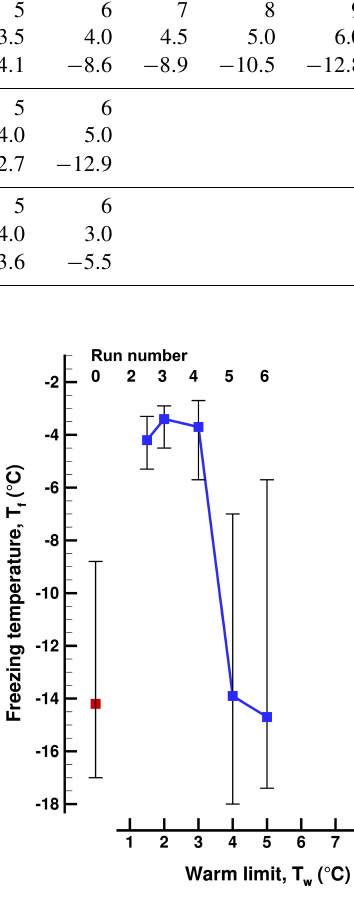
Figure 3. Freezing temperatures in the sequence of runs (Exp. A) with increasing warm limit, T w . The first bar on the left is for the initial run started at room temperature. The 50th percentile is indi- cated by the square symbols, and the vertical lines show the 5th- and 95th-percentile values.